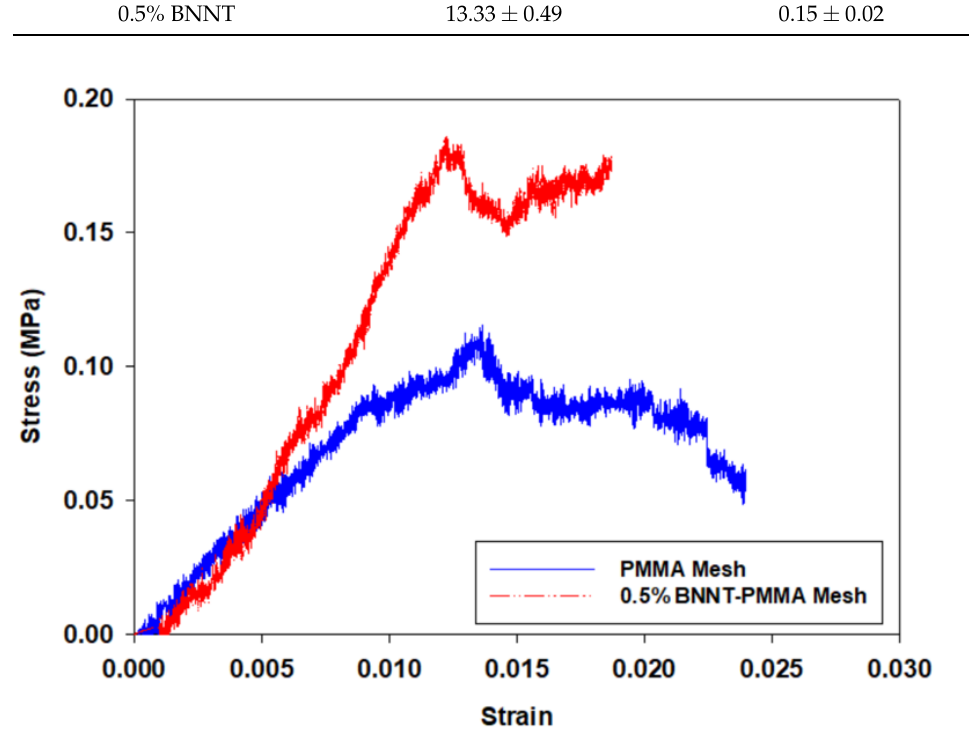
Figure 4. Sample of stress–strain curve extracted from the tensile tester for one mesh from PMMA and BNNT-PMMA